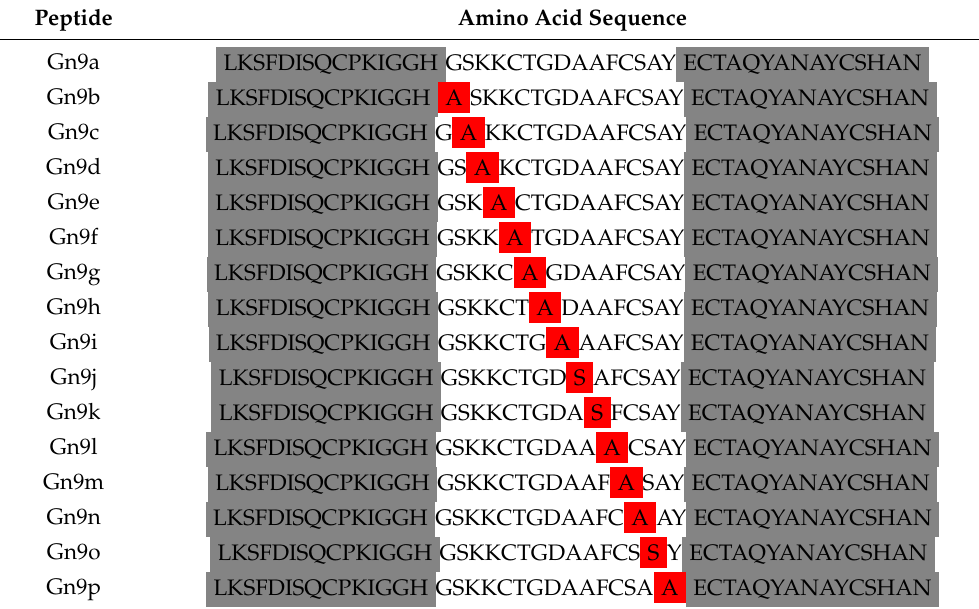
Table 3. The peptide sequences used for alanine-scanning mutagenesis of Gn9a. Peptide Amino Acid